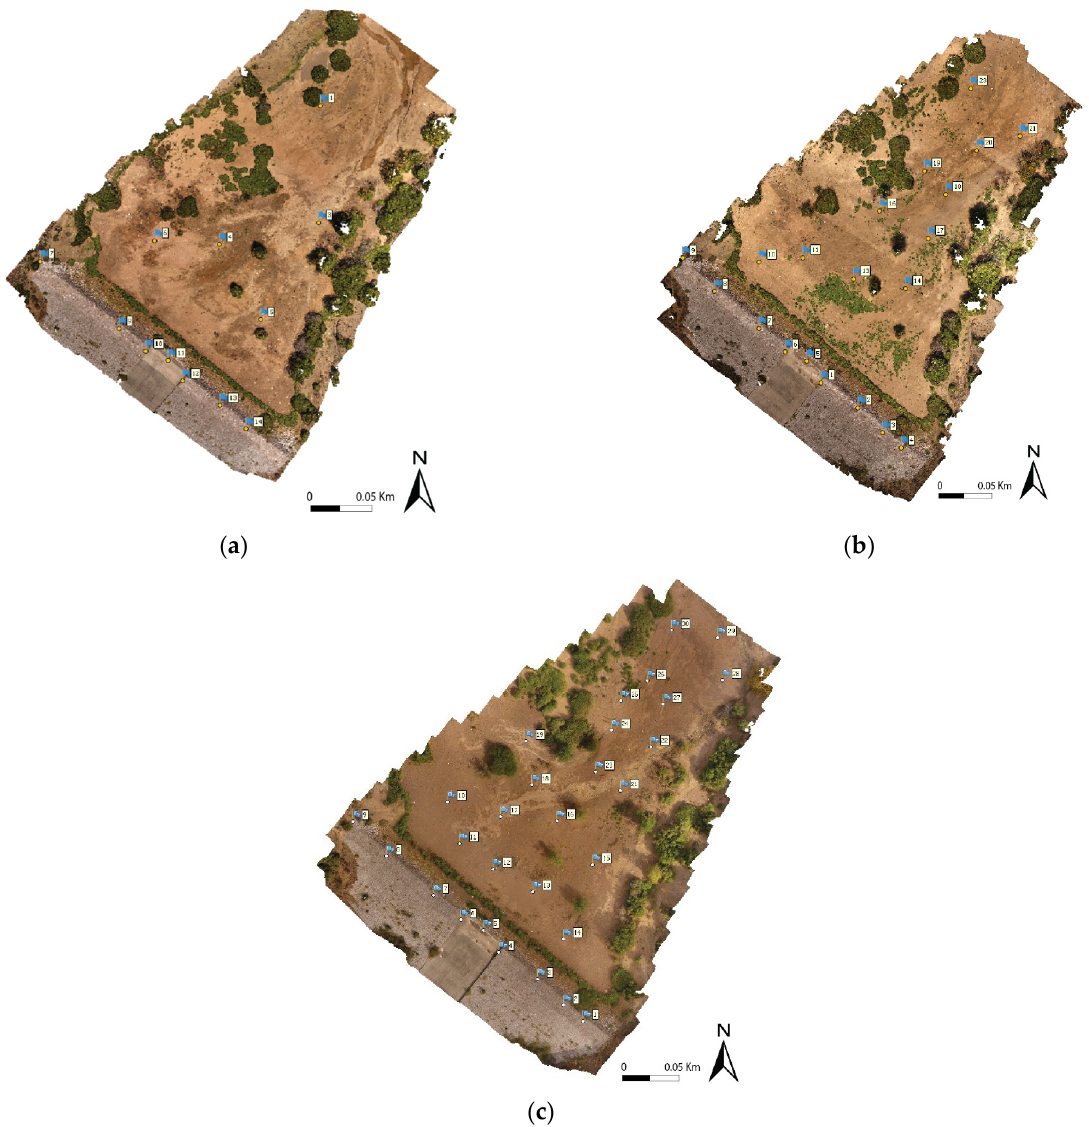
Figure 3. GCP locations on the three acquired orthomosaic images on ( a ) 28 August 2020; ( b ) 16 September 2021; ( c ) 13 October 2022. The numbering refers to the GCP